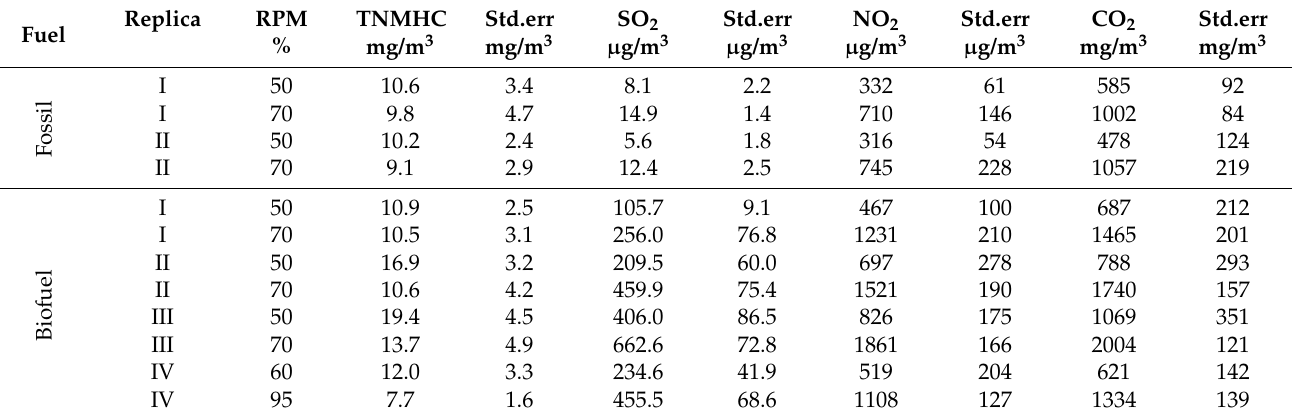
Table 2. Emission concentrations (reported as mean with the relative standard error) for volatile compounds measured during the combustion tests after accounting for the dilution factor and background